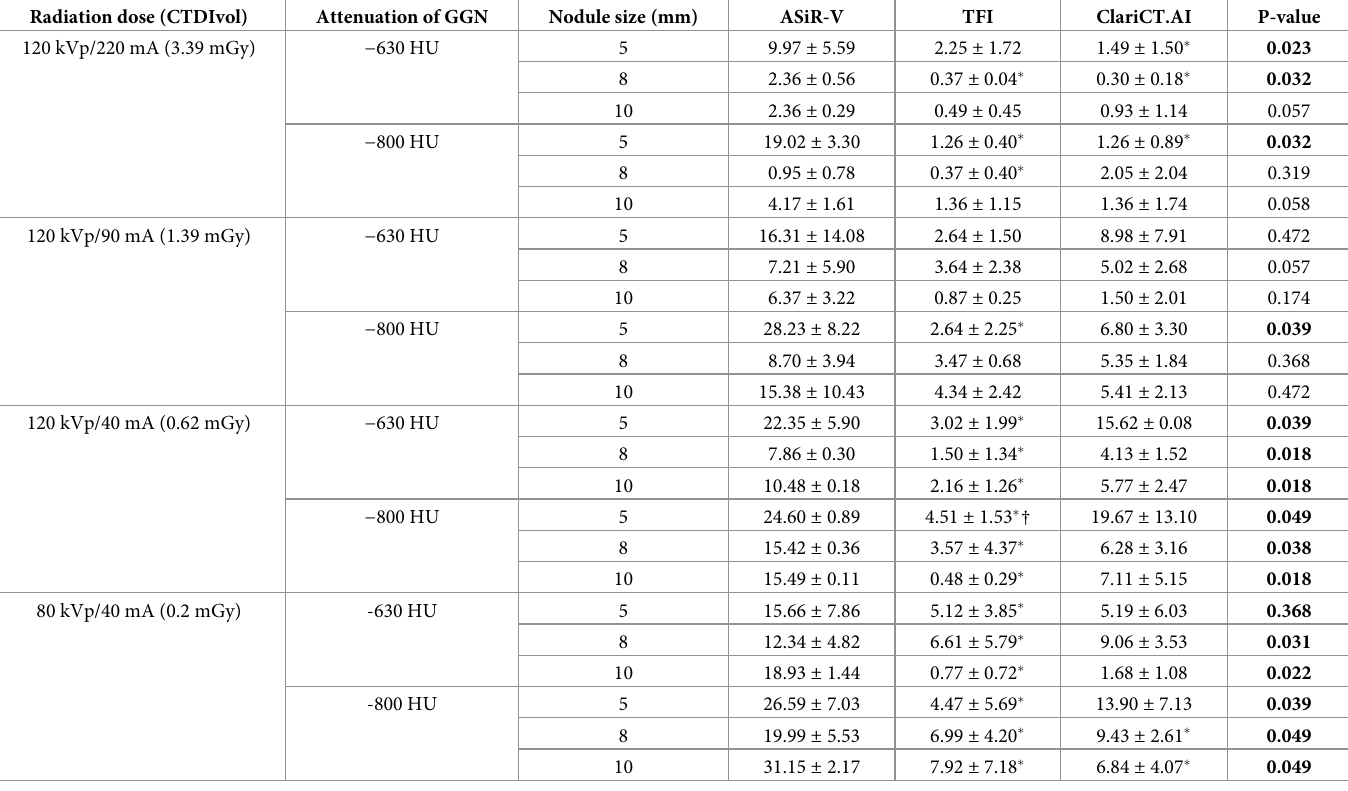
Table 5. Absolute percentage measurement error according to nodule size and attenuation of ground-glass nodules. Radiation dose